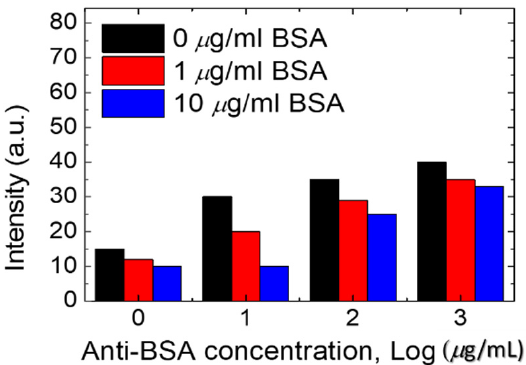
Figure 5. The intensities of immunodetection dye-doped liquid crystal (DDLC) multi-microfluidic chips immobilized with concentrations of 0–10 µg/mL bovine serum albumin (BSA) and concentra- tions of 0–1000 µg/mL of the BSA antibody.